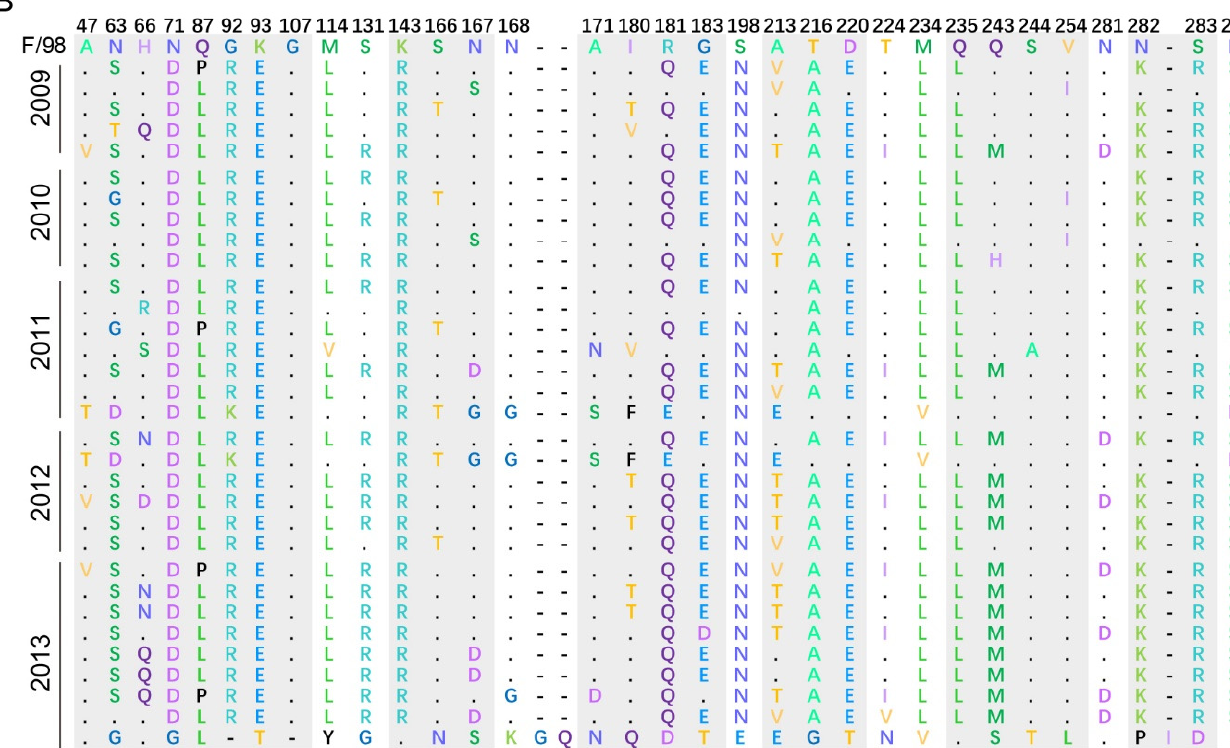
Figure 5. Distribution of mutational sites of the H9N2 subtype AIV at different time periods. ( A ) Sequence alignment of HA protein and F/98 protein of H9N2 subtype AIVs from 2002 to 2006. ( B ) Sequence alignment of HA protein and F/98 protein of H9N2 subtype AIVs from 2009 to 2013. The numbers in the first row indicate the location of the protein sites; the mutation sites reported are marked with a white background; the positive sites found in this study are shown with a light gray shade; and the strain name is on the left. The horizontal lines represent insertional mutations.